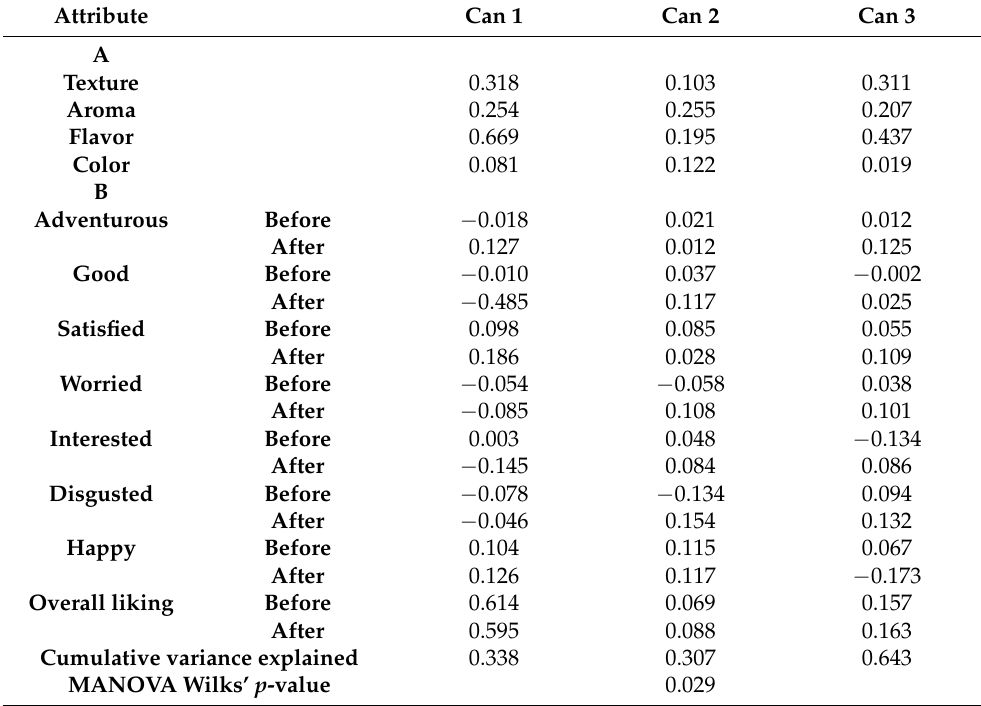
Table 6. Canonical structure describing group differences among low sodium roasted